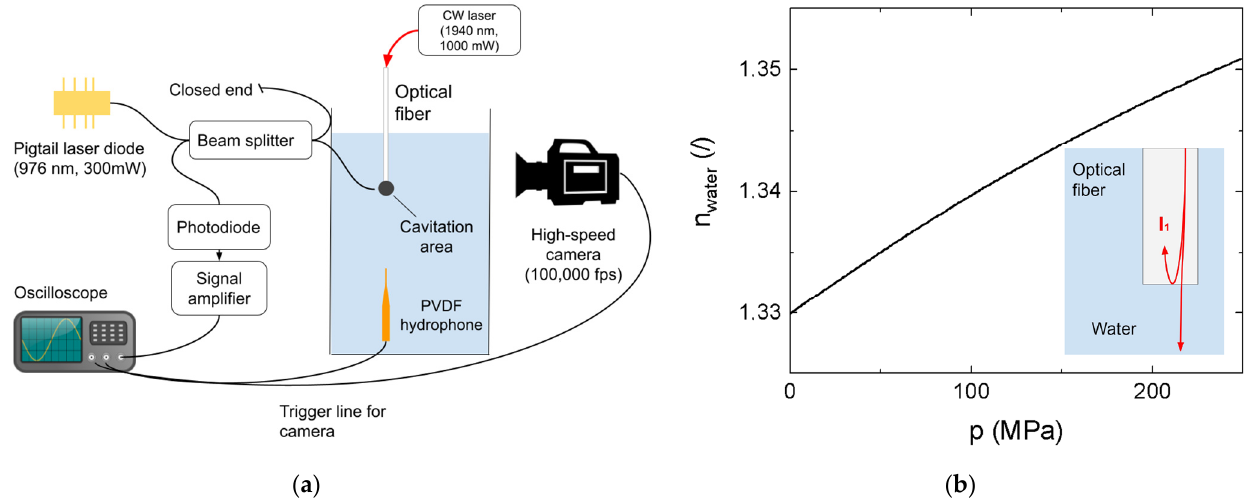
Figure 1. ( a ) Schematic representation of the measuring system; ( b ) water refractive index pressure dependence.